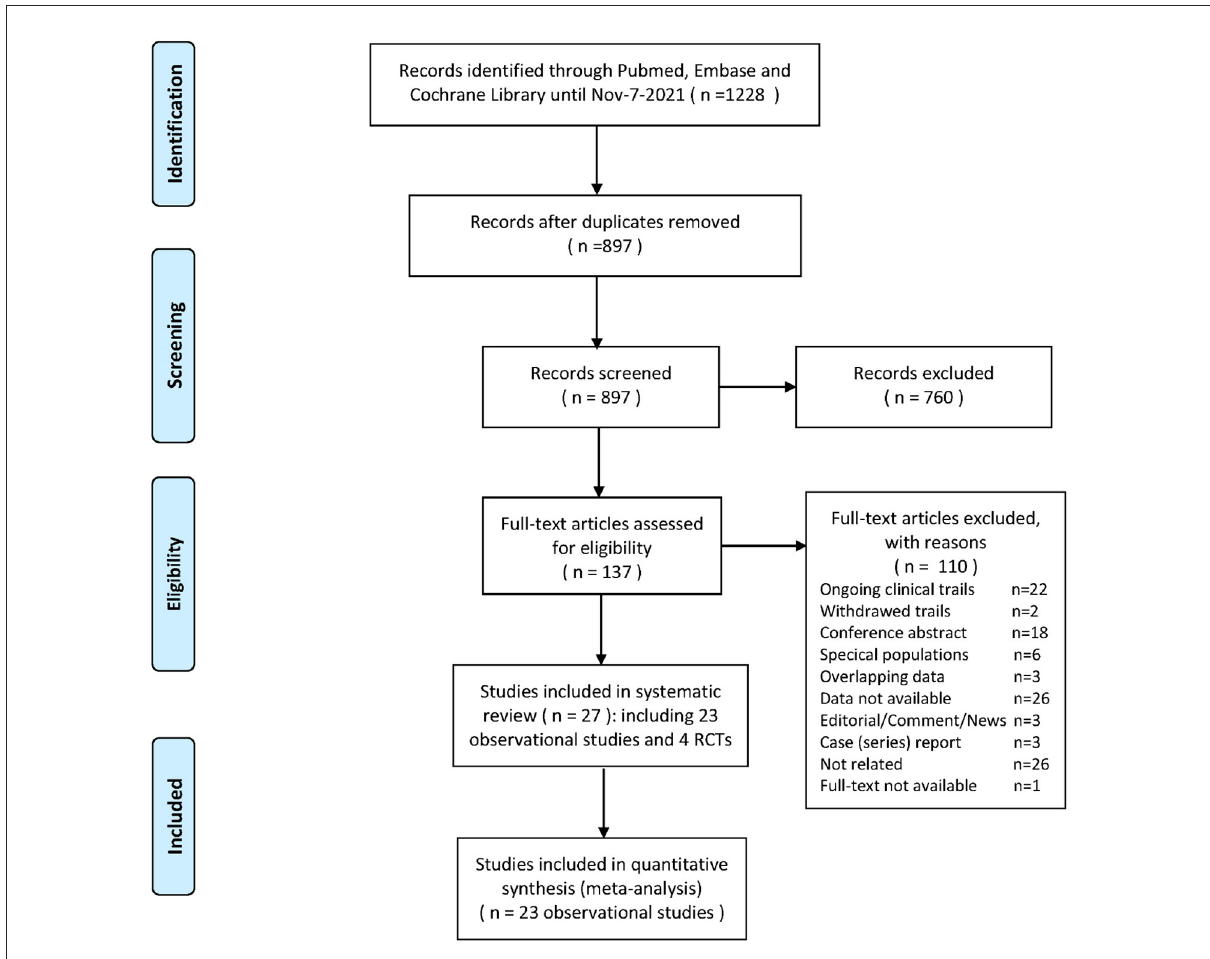
FIGURE1 Flowchart of the systematic